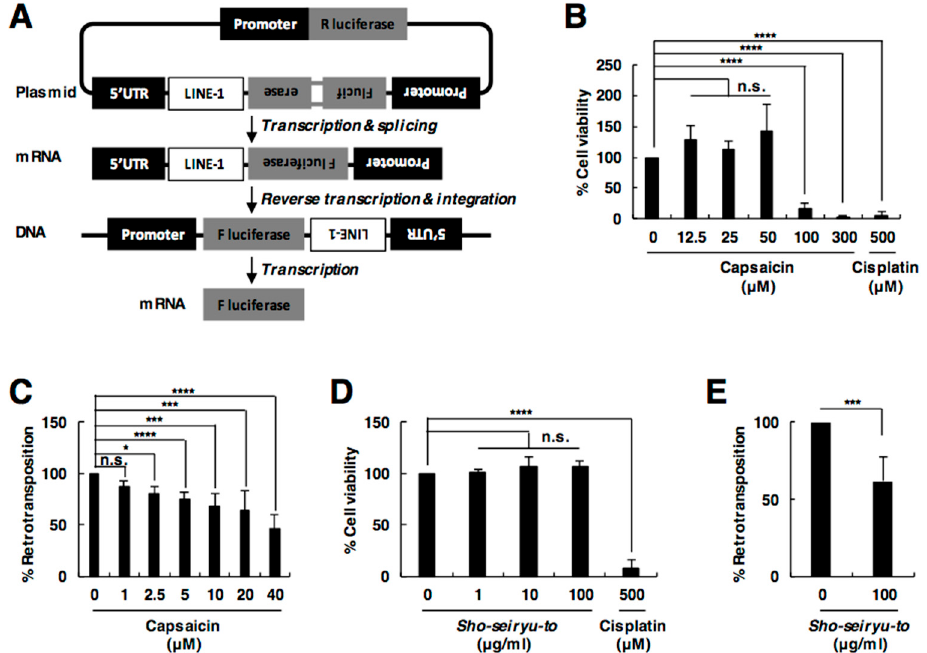
Figure 2. Capsaicin suppresses L1 retrotransposition. ( A ) The rationale for L1 retrotransposition assay. L1 with a retrotransposition reporter cassette is expressed under the L1 cognate promoter that is located in the 5 (cid:48) UTR of pYX014. The L1 retrotransposition reporter is the Firefly